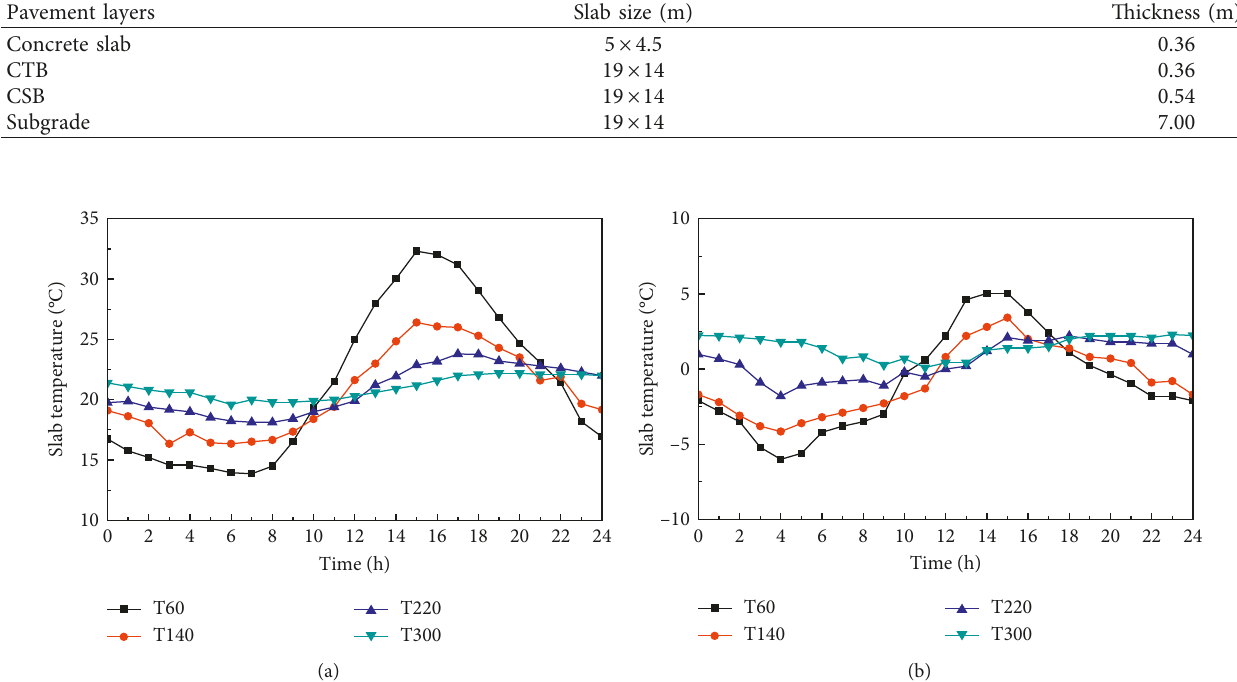
Figure 2: Temperature daily fluctuation curves in the concrete slab over different months. (a) August 14 th . (b) November 2 nd